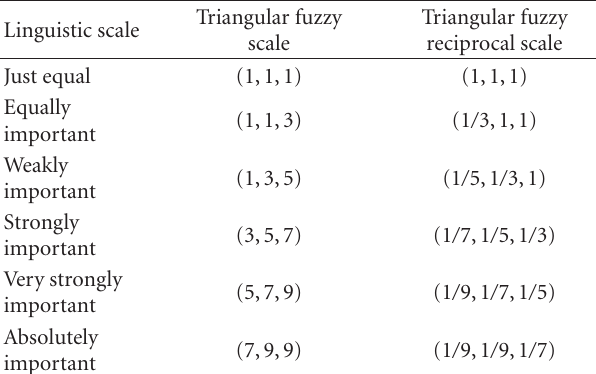
Figure 1: Performance evaluation framework of the research. Table 1: Membership function of linguistic